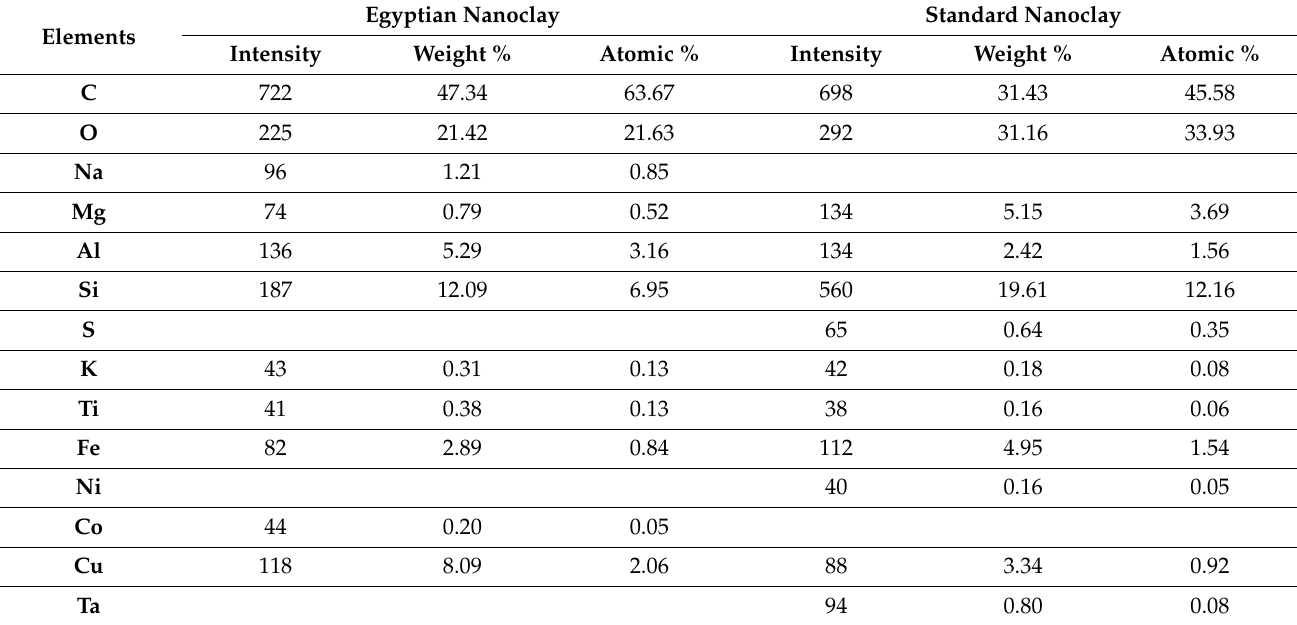
Table 3. EDS analysis of Egyptian nanoclay and standard